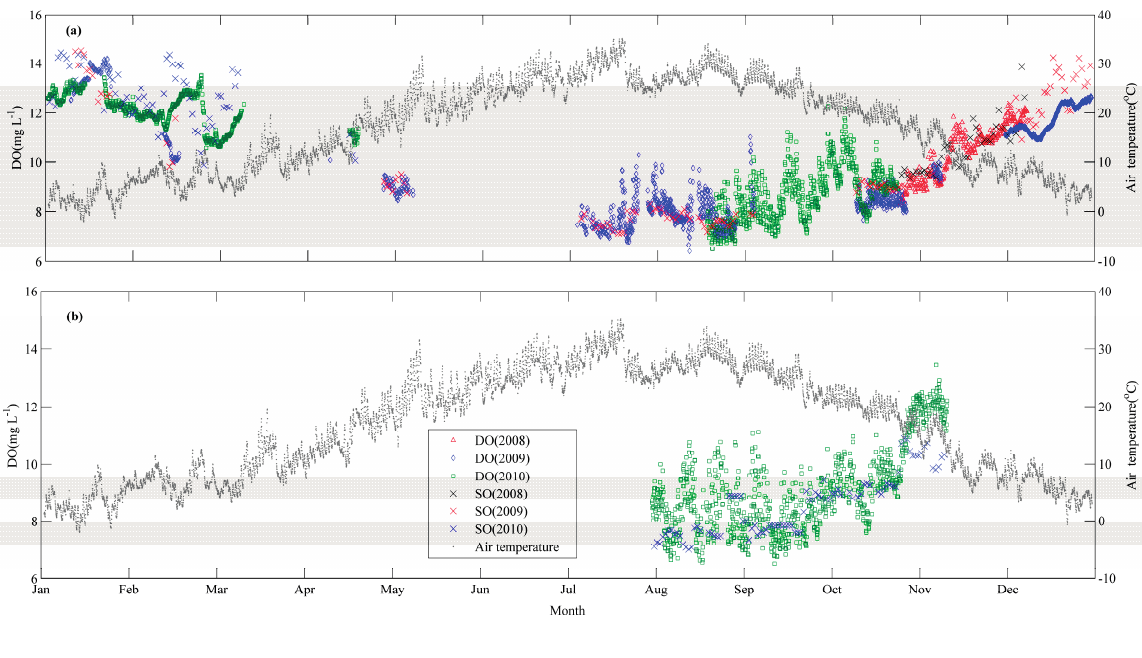
Figure 2. Temporal variation of dissolved oxygen (DO) and saturated oxygen (SO) concentrations at ( a ) Shangshancun (SSC) buoy station and ( b ) Jinshu (JS) buoy